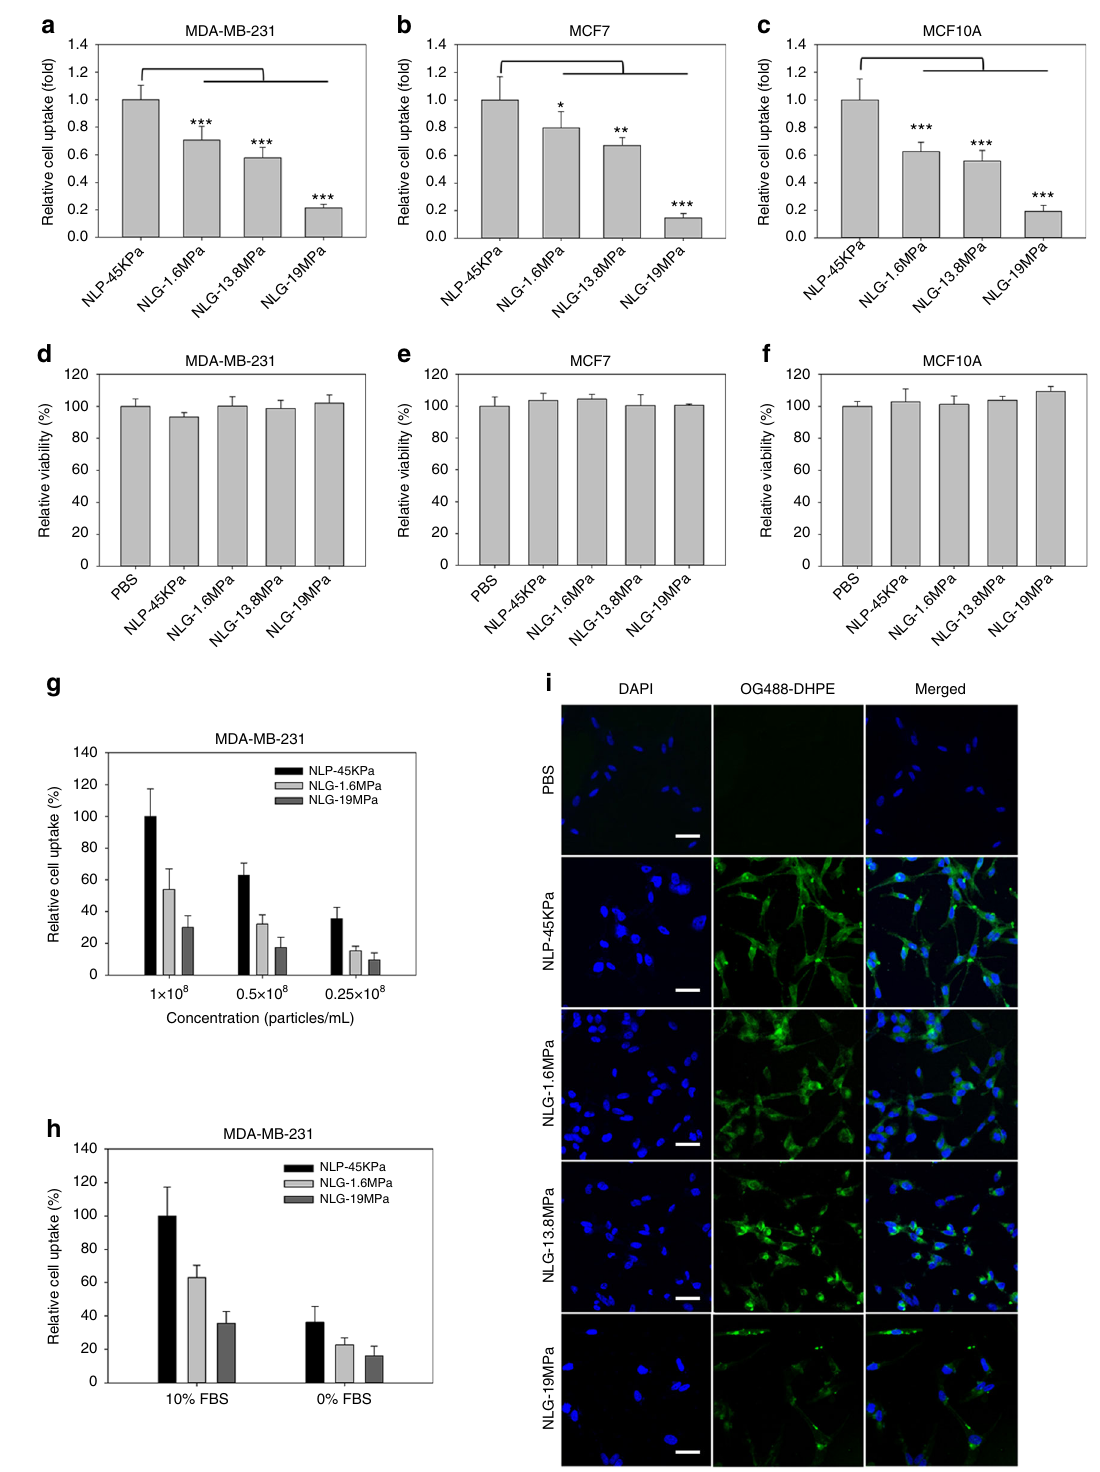
Fig. 2 Particle elasticity regulates in vitro cellular uptake. Relative cellular uptake of synthesized NLP and NLGs by MDA-MB-231 ( a ), MCF7 ( b ), and MCF10A ( c ) cells. Relative cytotoxicity of engineered NLP and NLGs in MDA-MB-231 ( d ), MCF7 ( e ), and MCF10A ( f ) cells. The concentration ( g ) and serum ( h ) dependence of particle elasticity-mediated cellular uptake in MDA-MB-231 cells. i Fluorescent microscope images of MDA-MB-231 cellular uptake of synthesized NLP and NLGs with varying elasticity. The scale bars represent 50 μ m. *** P < 0.001. The mean values and error bars are de fi ned as mean and S.D.,